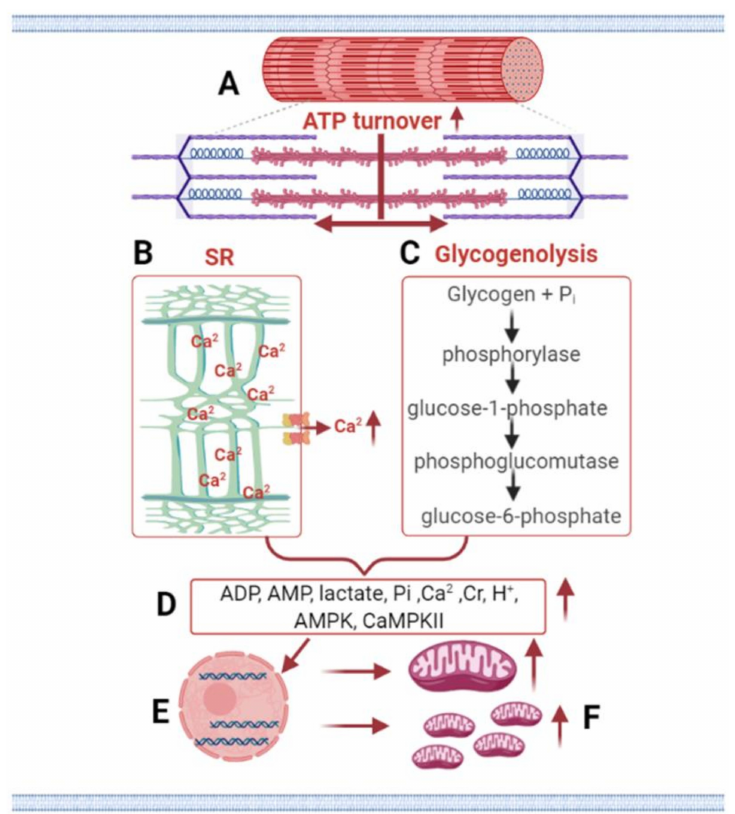
Figure 4. Schematic of the main signaling pathways through which high-intensity exercise elicits greater mitochondrial adaptations compared to lower intensities of exercise. Exercising at a higher intensity requires greater adenosine triphosphate turnover ( A ) and increases calcium release from sarcoplasmic reticulum; ( B ) carbohydrate oxidation, particularly from muscle glycogen, dominates at higher exercise intensities, compared to exercising at a lower intensity. ( C ) This results in a greater accumulation of metabolites, such as adenosine diphosphate, adenosine monophosphate, lactate, inorganic phosphate, creatine, calcium, hydrogen ion, adenosine monophosphate-activated protein kinase, and calcium/calmodulin-dependent protein kinase II, ( D ) causing greater rates of gene expression, ( E ) which promotes greater mitochondrial protein synthesis rates and greater mitochondrial content. ( F ) ADP, adenosine diphosphate; AMP, adenosine monophosphate; AMPK, adenosine monophosphate-activated protein kinase; ATP, adenosine triphosphate; Ca 2 , calcium; CaMPKII, calcium/calmodulin-dependent protein kinase II; Cr, creatine; H + , hydrogen ion; Pi, inorganic phosphate; SR; sarcoplasmic